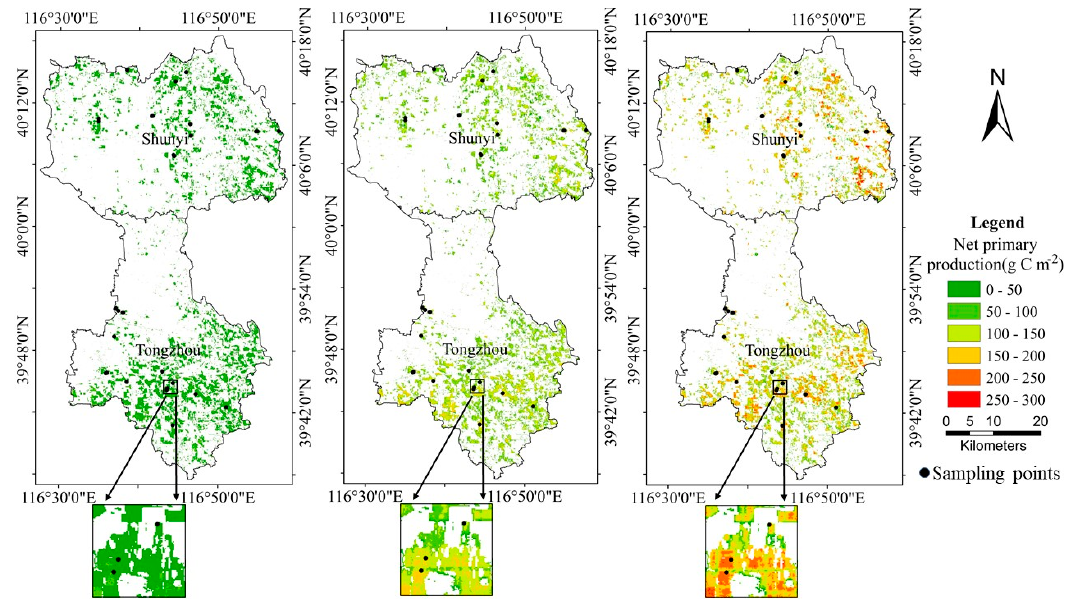
Figure 5. Spatial distribution of winter wheat net primary production (NPP) from March to May, 2009: ( a ) March; ( b ) April; ( c ) May.